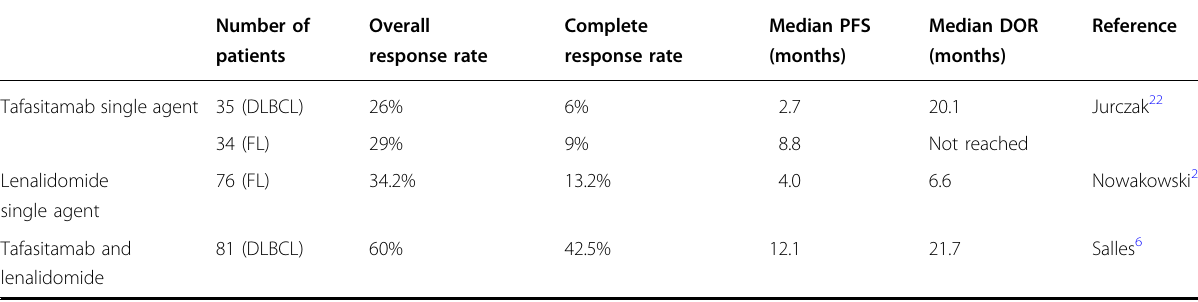
Table 1 Tafasitamab monotherapy vs L-mind regimen in